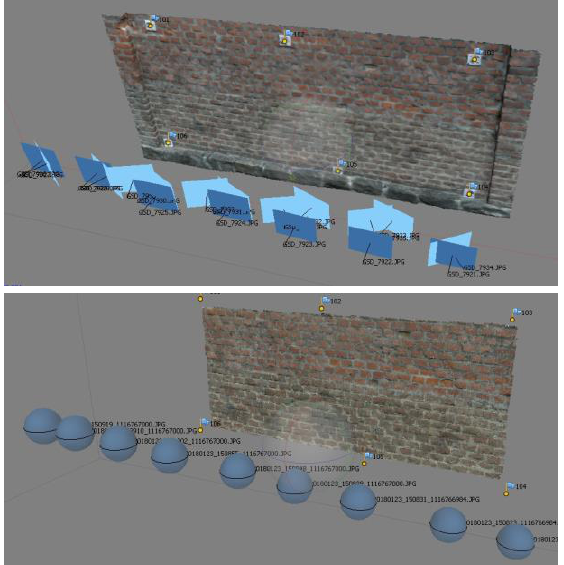
Figure 7. Reconstruction of a planar wall with pinhole and spherical cameras. In the case first case, convergent images provide a better triangulation in space. In the second one, there is no reason to rotate the camera.